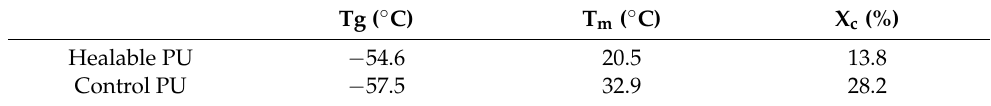
Table 5. Tg, T m and X c of the healable and control bio-based 2K PU.